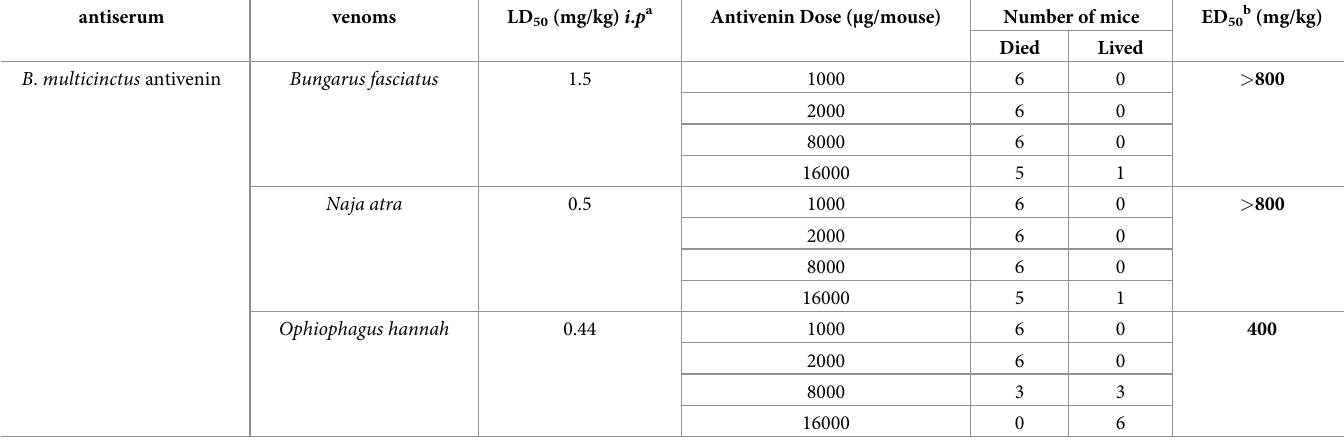
Table 3. The protective effects of antiserum against different snake venoms.